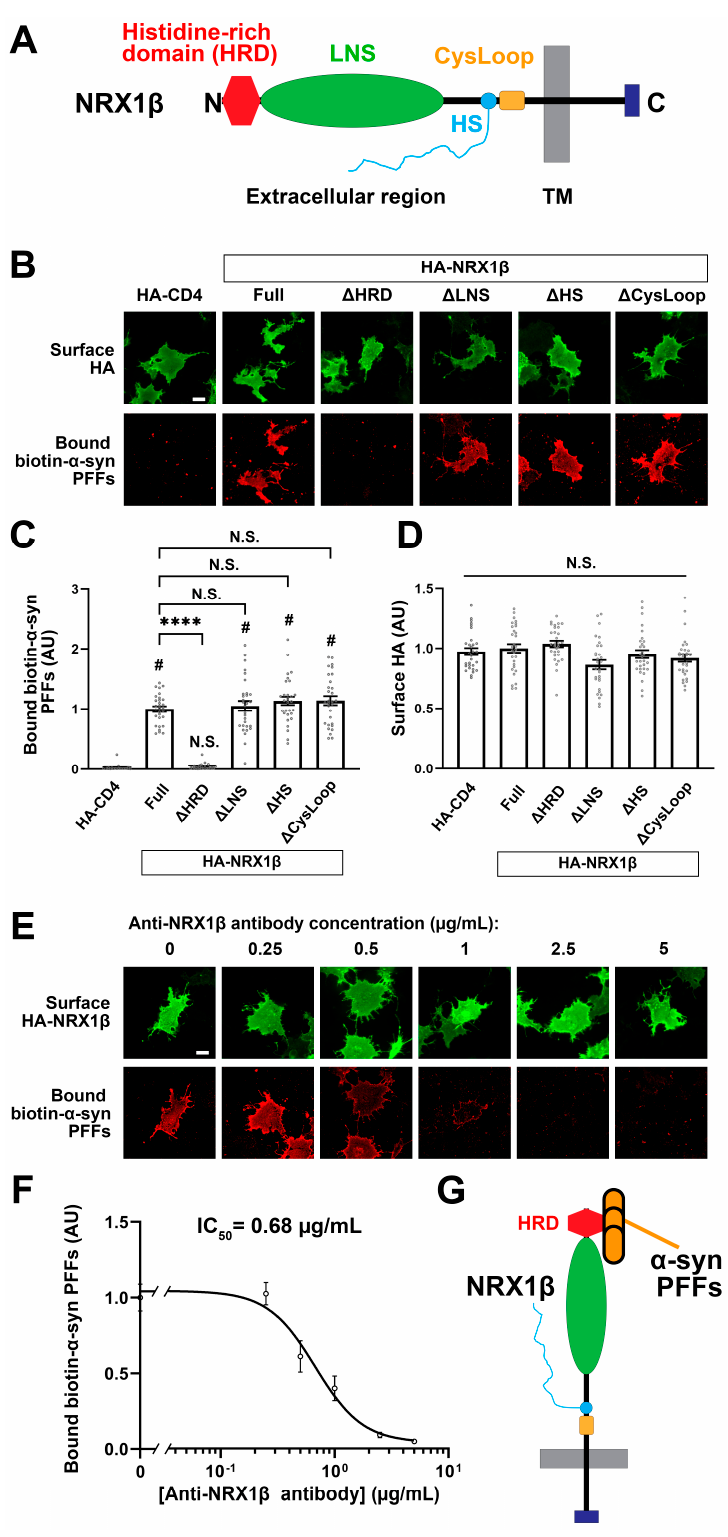
5 Figure 5. The N-terminal histidine-rich domain (HRD) of NRX1 β is responsible for the binding of α -syn PFFs to NRX1 β . ( A ) A diagram showing the domain structure of NRX1 β . HRD: the histidine- rich domain (HRD), LNS: laminin-neurexin-sex hormone binding globulin, HS: a heparan sulfate modification site, CysLoop: cysteine loop region, TM: transmembrane region, N and C: N- and C-terminals, respectively. ( B ) Representative images showing the binding of 1 µ M biotin- α -syn